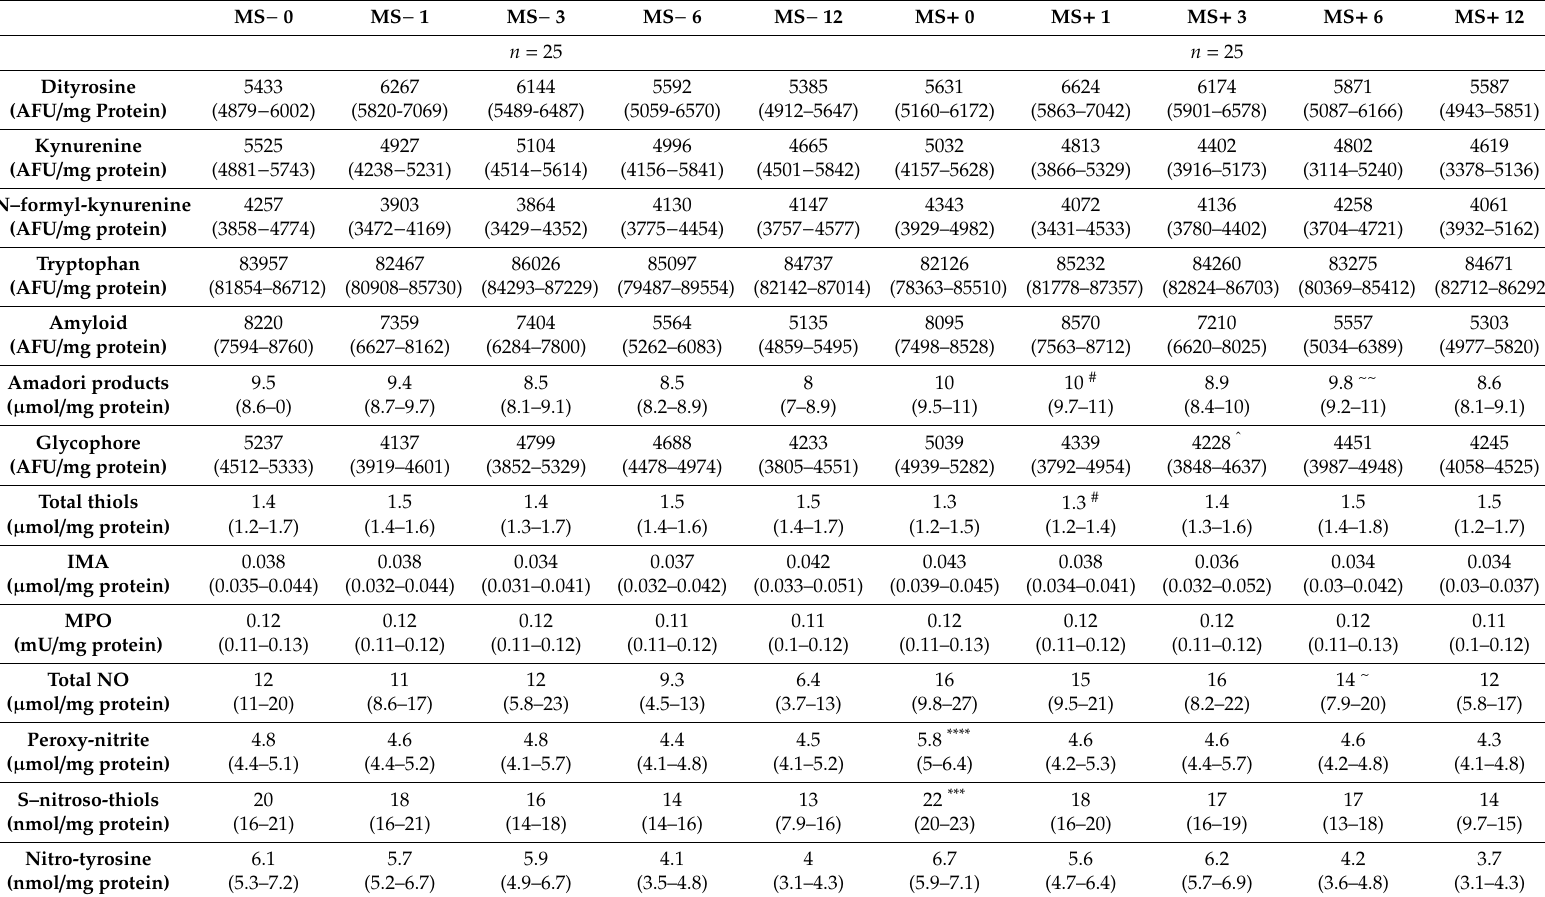
Table 2. Comparison between morbidly obese patients without metabolic syndrome (MS − ) and morbidly obese patients with metabolic syndrome (MS + );